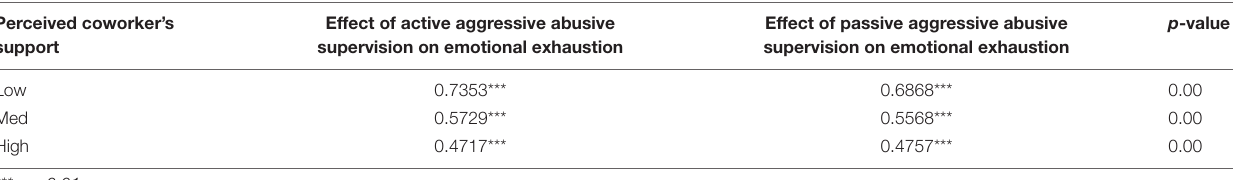
TABLE 6 | Moderation results with active-aggressive and passive-aggressive abusive supervision for different levels of coworker’s support.